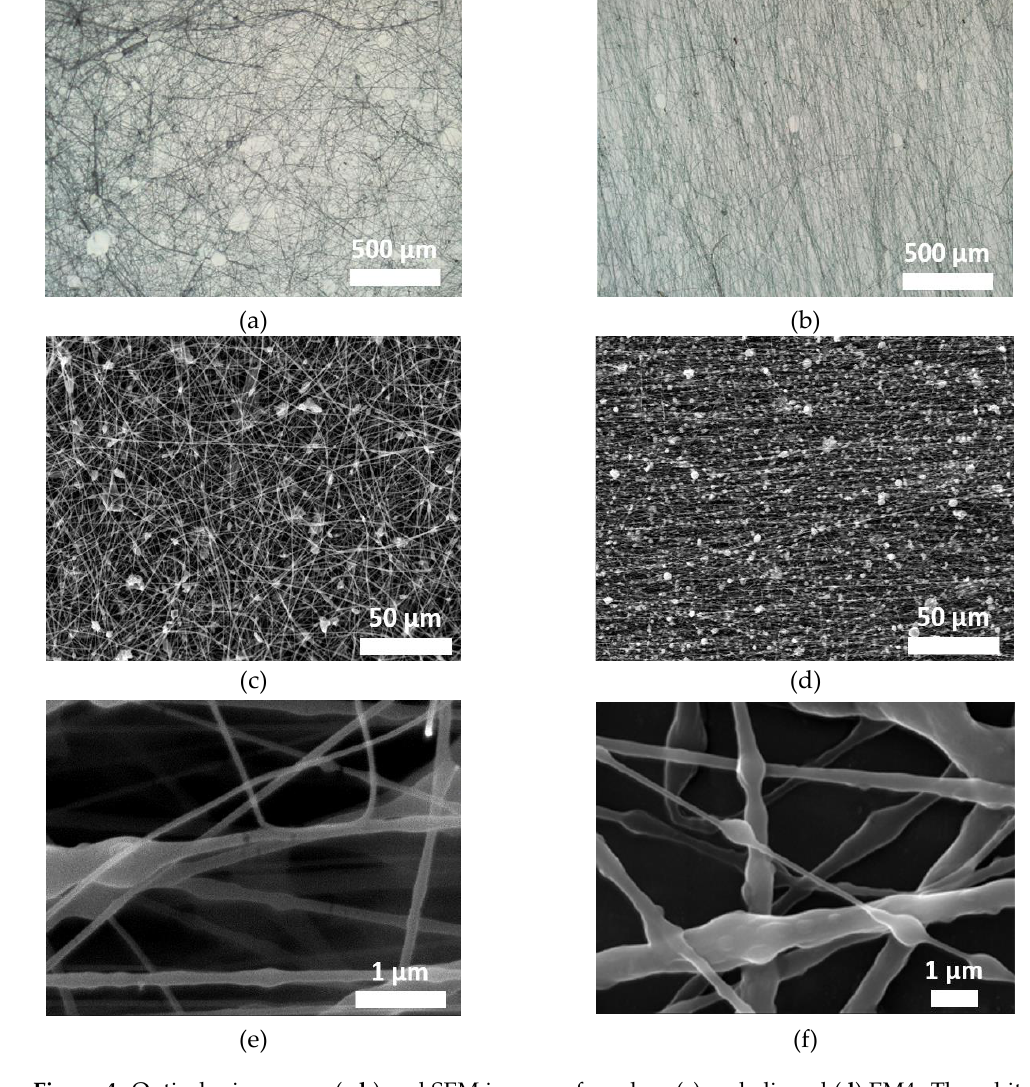
Figure 4. Optical microscopy ( a , b ) and SEM images of random ( c ) and aligned ( d ) EM4. The white circles indicate the presence of TrGO in the aligned fibers of EM4 ( e ) and the absence of TrGO in aligned fibers in EM3 ( f ).